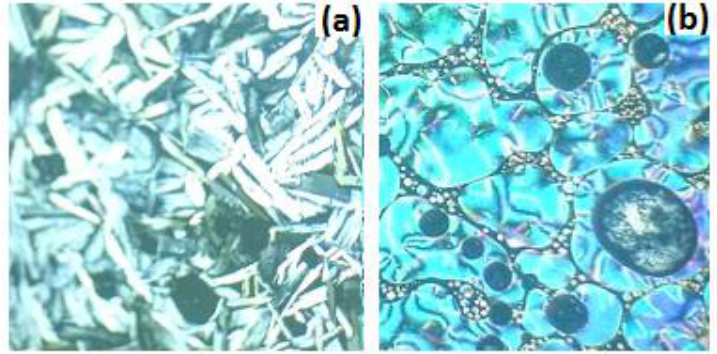
Figure 2. Mesophase textures observed by POM during heating cycle of compound II/C14 smectic A phase at 24.0 °C ( a ) and compound I/C14 nematic phase at 75.0 °C ( b ).